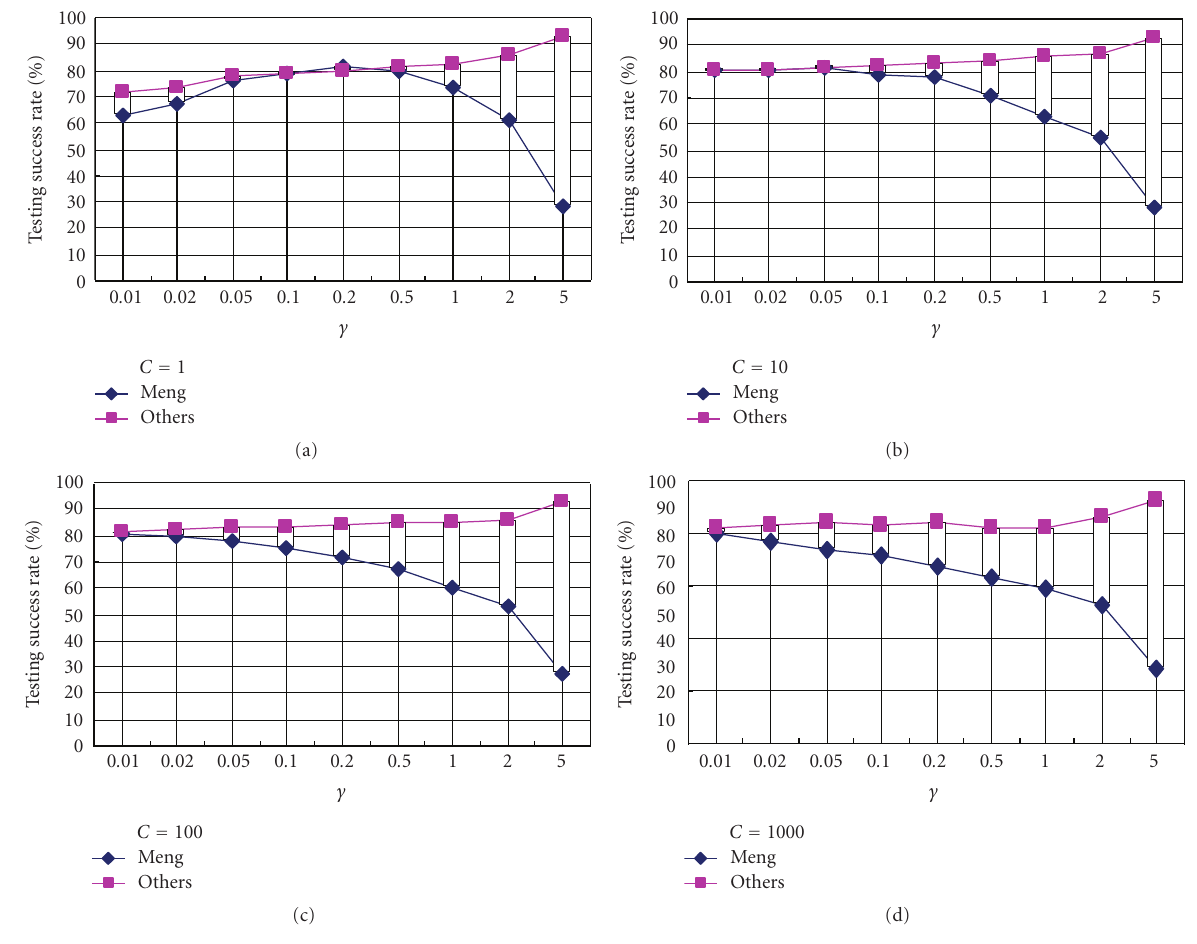
Figure 7: Success rate of model Meng versus Others parameterized with γ .